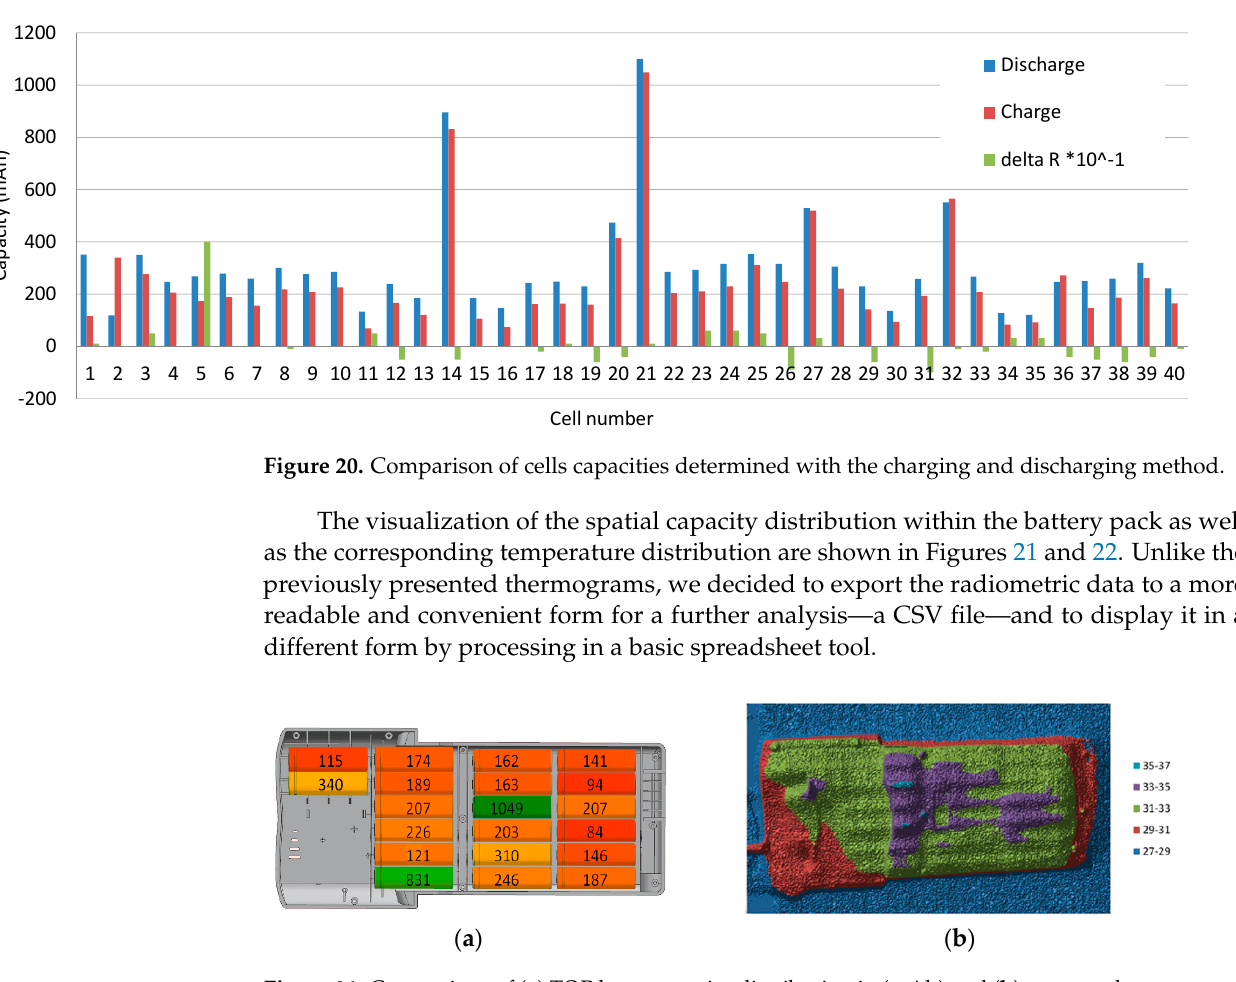
Figure 21. Comparison of ( a ) TOP layer capacity distribution in (mAh) and ( b ) measured temperature values in (°C).